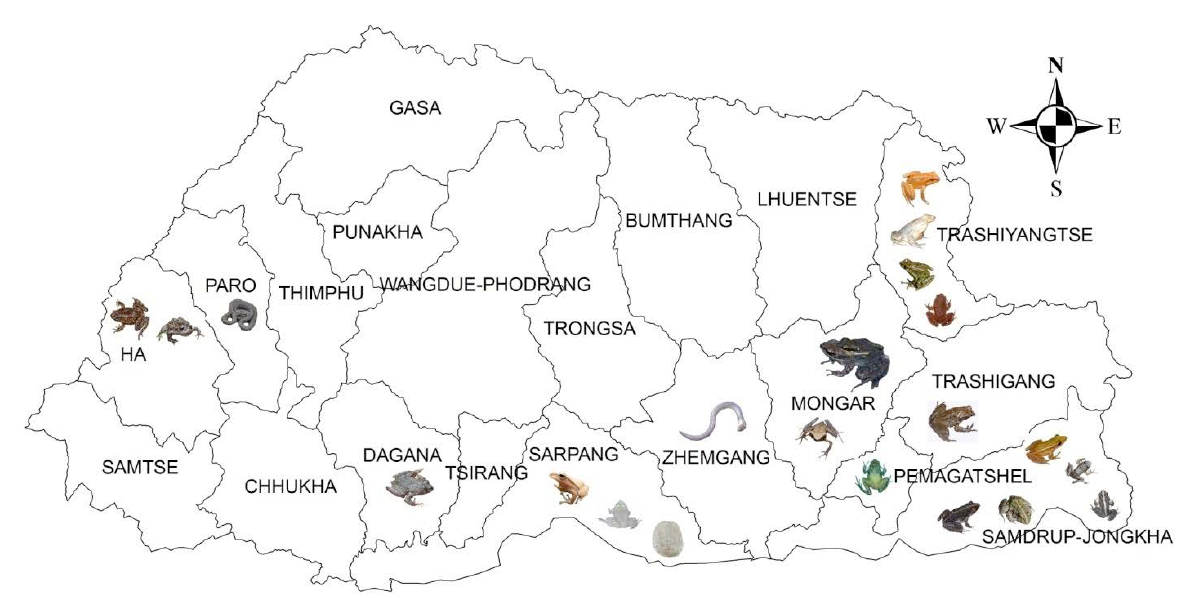
Figure 1. Map showing the data collection areas. © Jigme Tshelthrim